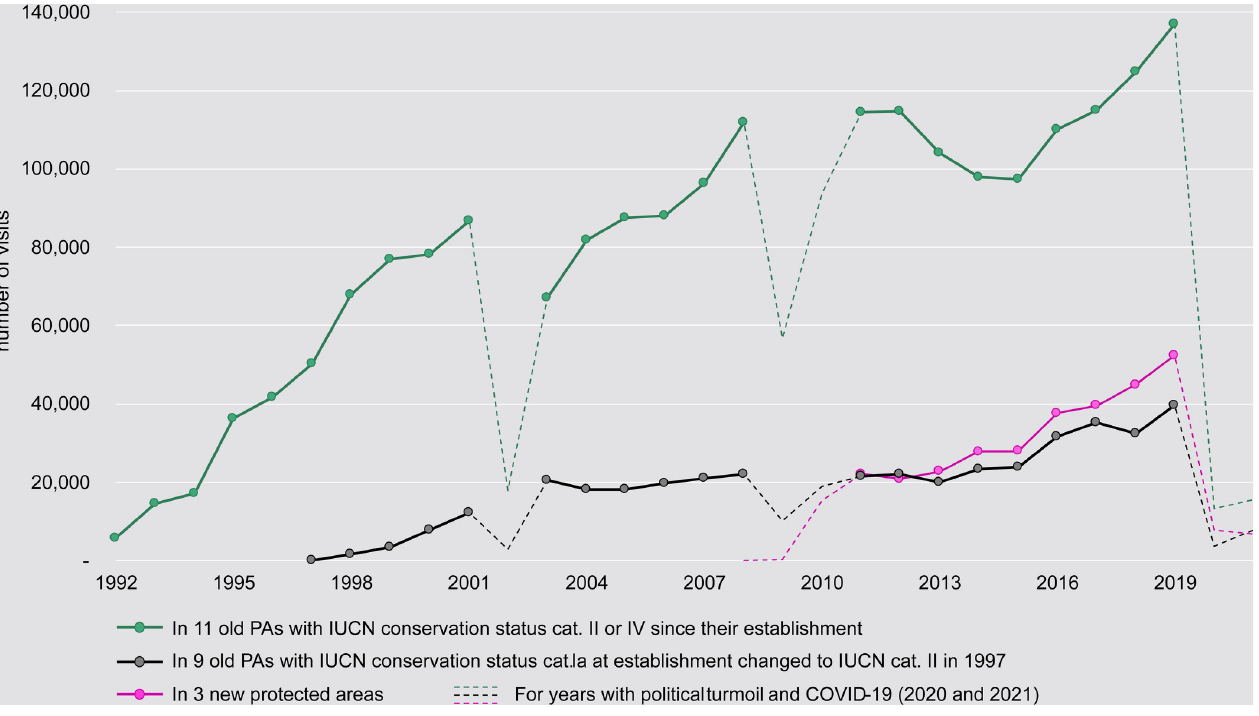
Fig 3. Evolution of number of tickets sold for NPs which were Strict Nature Reserves before 1997, as compared to NP which were established as IUCN cat. II since their creation. Years 2002, and 2009–2010 have been excluded from the main curve and appear on the dashed